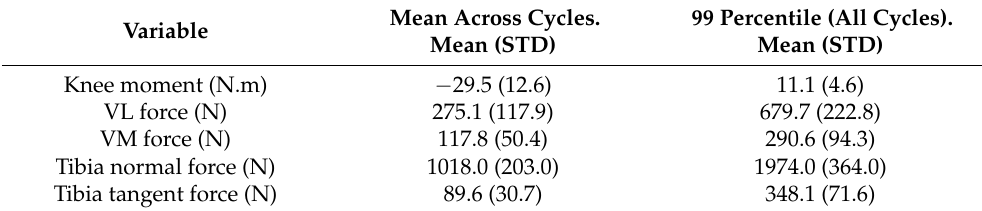
Table 2. Summary of dynamic variables estimated using the full dynamic model FDM *. n = 15. Variable